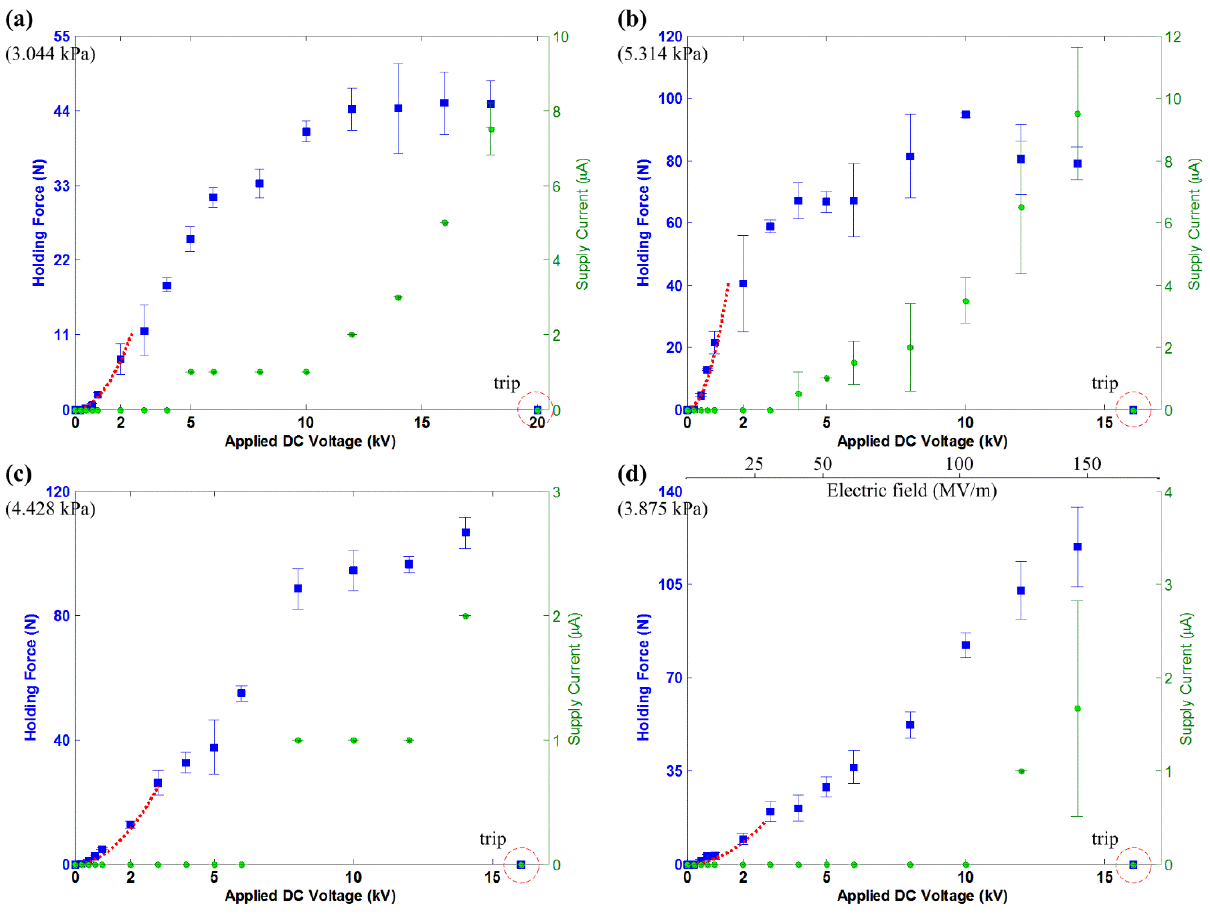
Figure 11. The measured holding force and supply current for the electroadhesion actuators on the glass panel, shown with the tripped voltage level. The dashed line describes a quadratic fit over the data, which follows Equation (13). ( a ) B7×4, c = 1.8; ( b ) B7×5, c = 18; ( c ) B7×6, c = 2.8.; ( d ) B7×8, c = 2.0. (The experiment on glass panel is shown in the supplementary